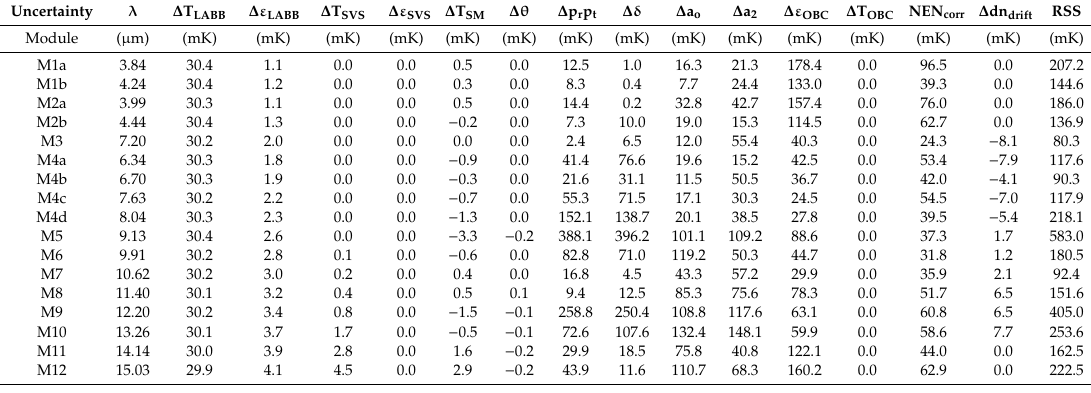
uncertainty, Δε OBC , OBC blackbody temperature uncertainty, Δ T OBC , correlated noise, NEN corr , and offset drift, Δ dn.